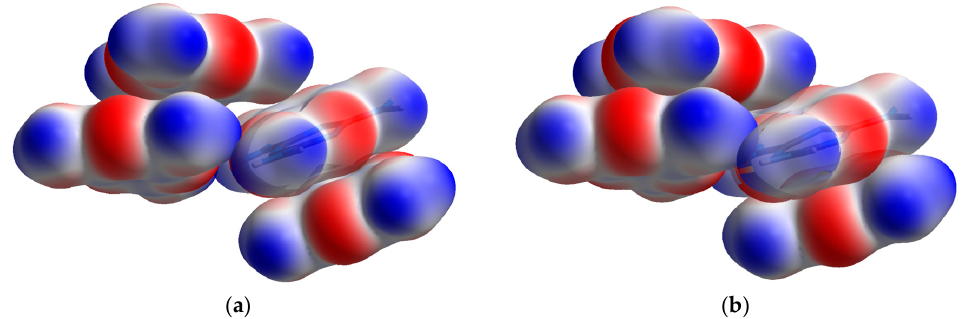
Figure 12. Electrostatic potential surfaces of neighboring melamine molecules at 6.33(5) ( a ) and 36.21(5) ( b ) GPa, scaled from − 0.0928 to 0.1388 au. Regions in red are electron-rich, while regions in blue are electron deficient. With pressure, distance between melamine ring centroids oriented in parallel planes decreases, and the offset angle to the next pair of molecules decreases.